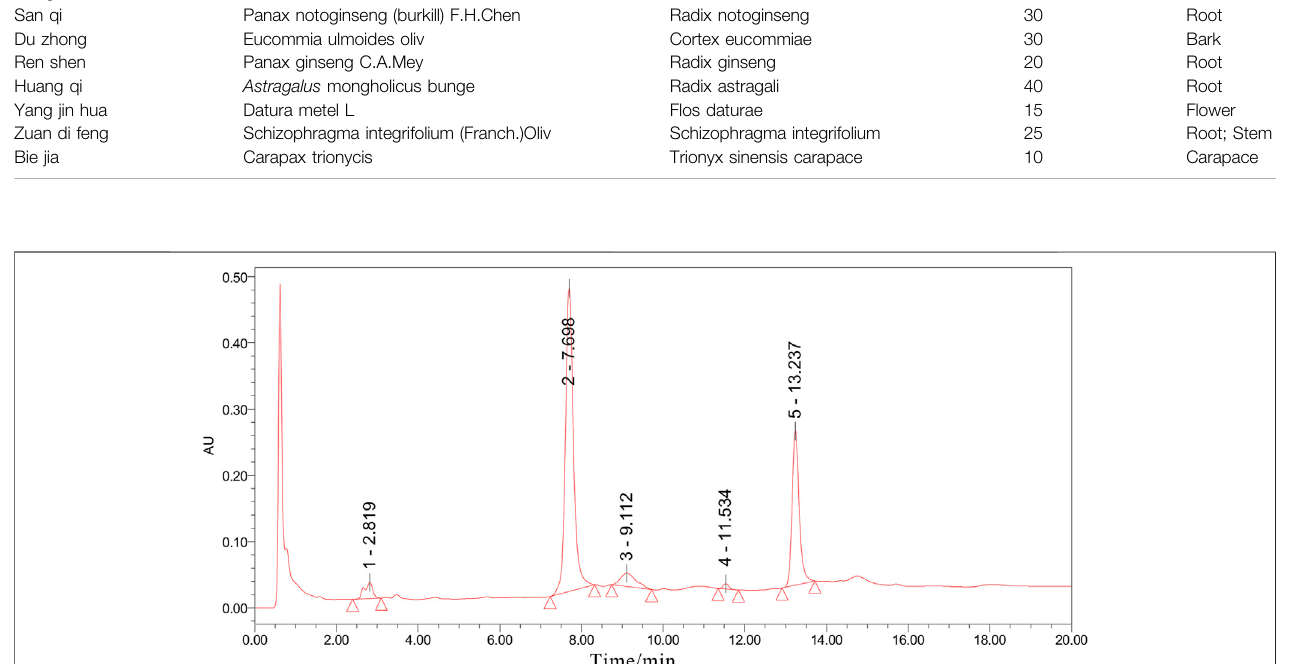
FIGURE 1 | The UPLC analysis result of Osteoking solution. All chromatographic peak signaling was recorded at 260 nm and the peak area was integrated under the instrument ’ s protocol. Peak 1 – 5 respectively indicated Astragaloside, Aucubin, Ginsenoside, Notoginsenoside, and Hesperidin.